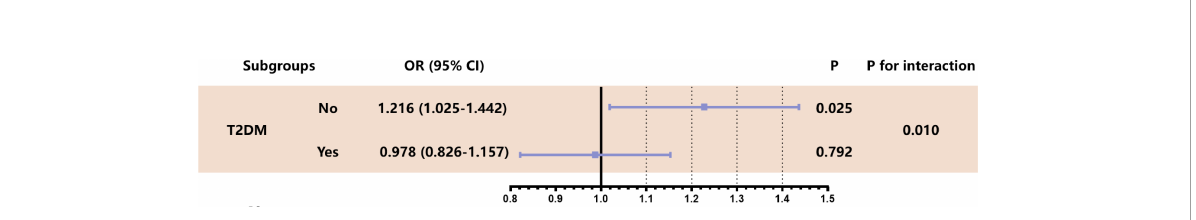
FIGURE 2 Strati fi ed analysis of eGDR predicting ISR in T2DM subgroup. The analysis was adjusted for Model 4 except for variates applied for grouping. OR was evaluated by per 1-unit decrease of eGDR. eGDR estimated glucose disposal rate calculated, ISR in-stent restenosis, OR odds ratio, T2DM type 2 diabetes mellitus.